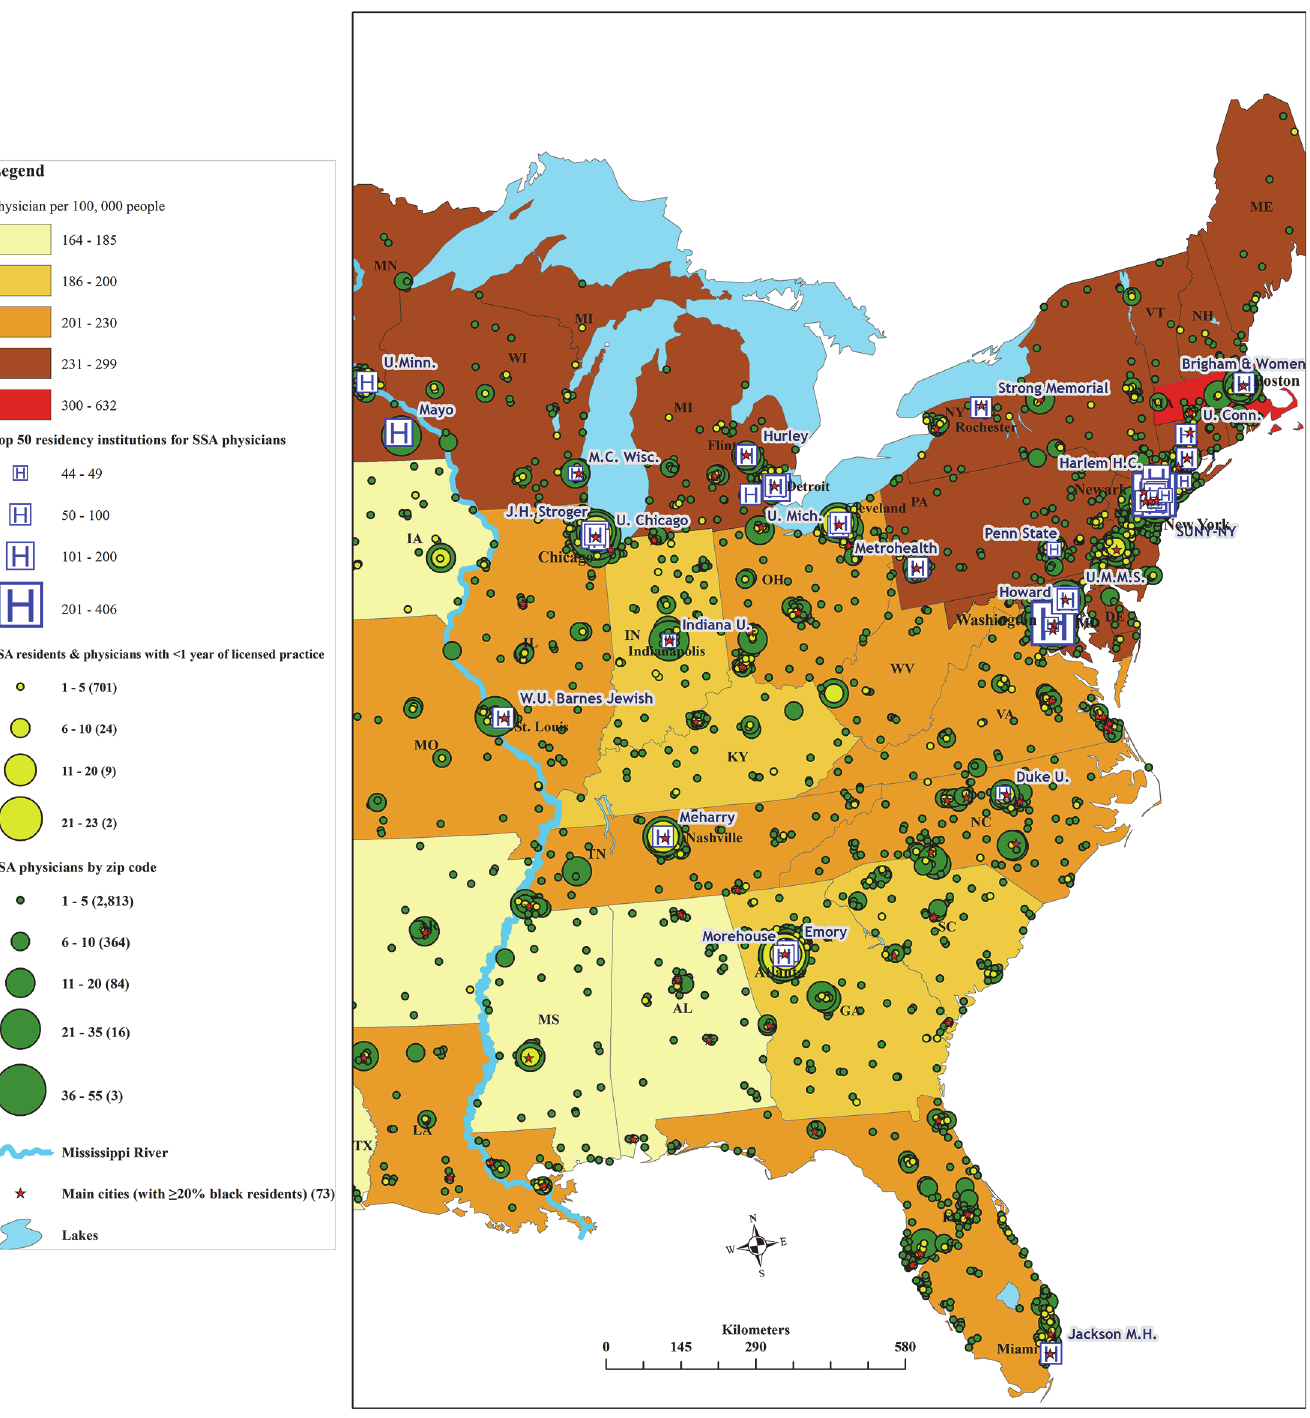
Fig 4. Main residency institutions of Sub-Saharan African migrant physicians in the Eastern Region of the United States. Note: Full names of residency programs appearing on the map are provided as supporting information (S1 Table). Data sources: Redi-Med Data Interactive Medical Database System [51]; Environmental Systems Research Institute [62]; Association of American Medical Colleges [63].